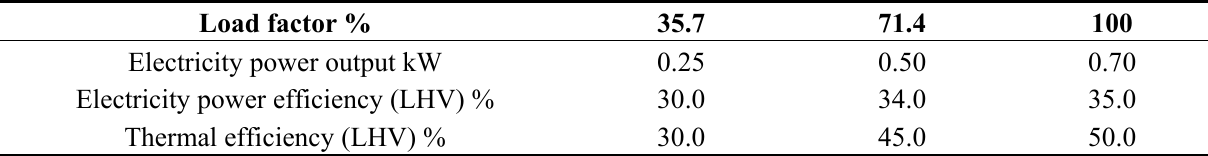
Table 2. Partial load performance of PEFC unit.